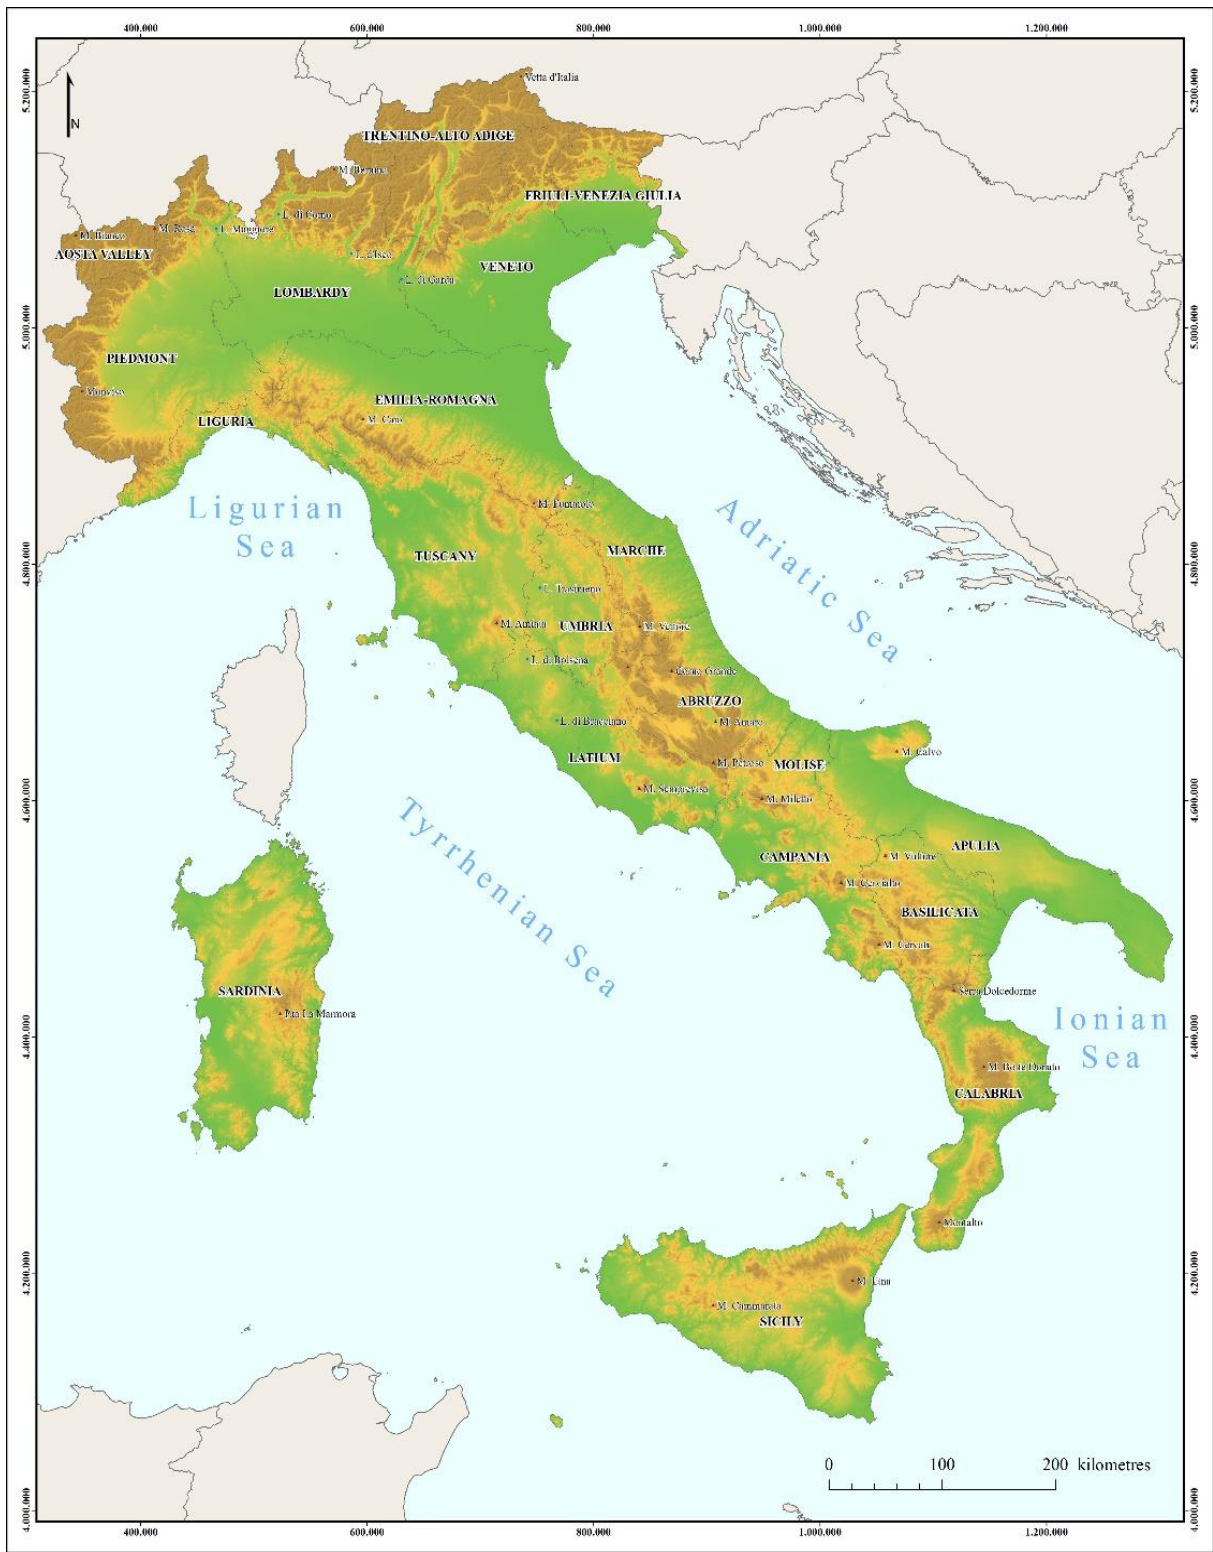
Figure 2. Study area — Italy.